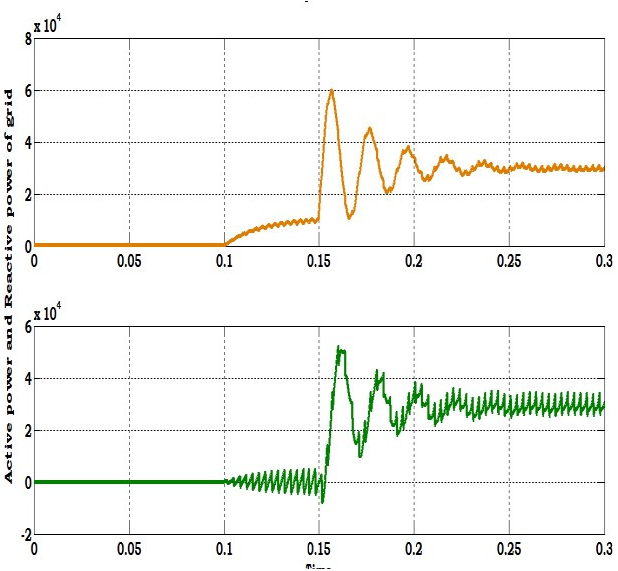
Figure 6. Active Power and Reactive Power of Grid